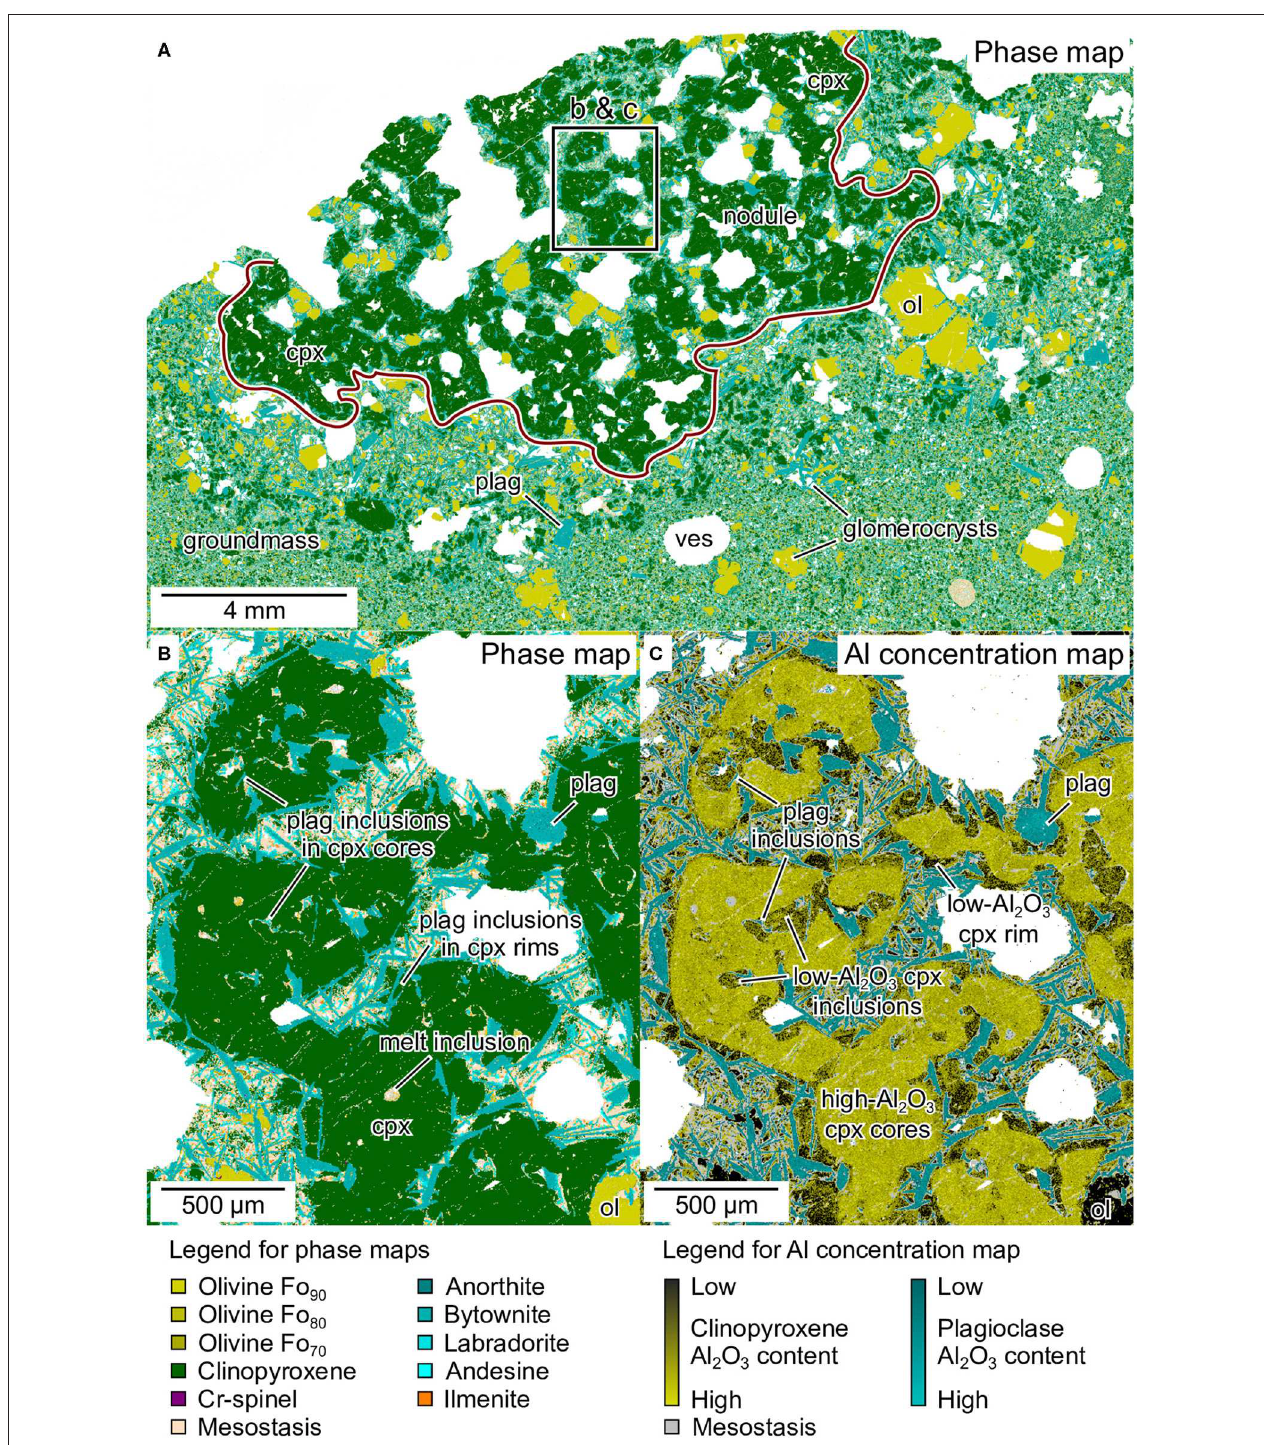
FIGURE 2 | Phase and Al concentration maps of a wehrlitic nodule in sample JM27 from the Borgarhraun lava flow in North Iceland obtained by QEMSCAN. (A) The wehrlitic nodule is composed of clinopyroxne with subordinate olivine and rare plagioclase. It also contains pockets and channels of crystalline groundmass that are contiguous with the lava groundmass, indicating that the nodule was porous at the point of lava flow emplacement. Macrocrystic and glomerocrystic olivine, plagioclase and clinopyroxene also occur in the lava groundmass. (B) Plagioclase inclusions are present in the cores and rims of clinopyroxenes in the wehrlitic nodule. (C) Clinopyroxene cores in the wehrlitic nodule have relatively high Al 2 O 3 contents, whereas clinopyroxene rims have relatively low Al 2 O 3 contents. Plagioclase inclusions in clinopyroxene cores are associated with inclusions of low-Al 2 O 3 clinopyroxene that are not evident in phase maps.